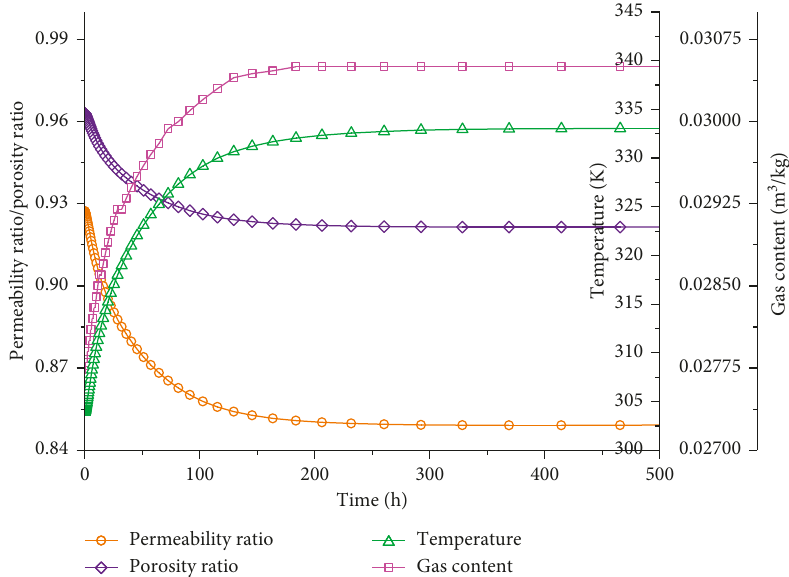
Figure 8: Permeability distribution of the monitoring point A.